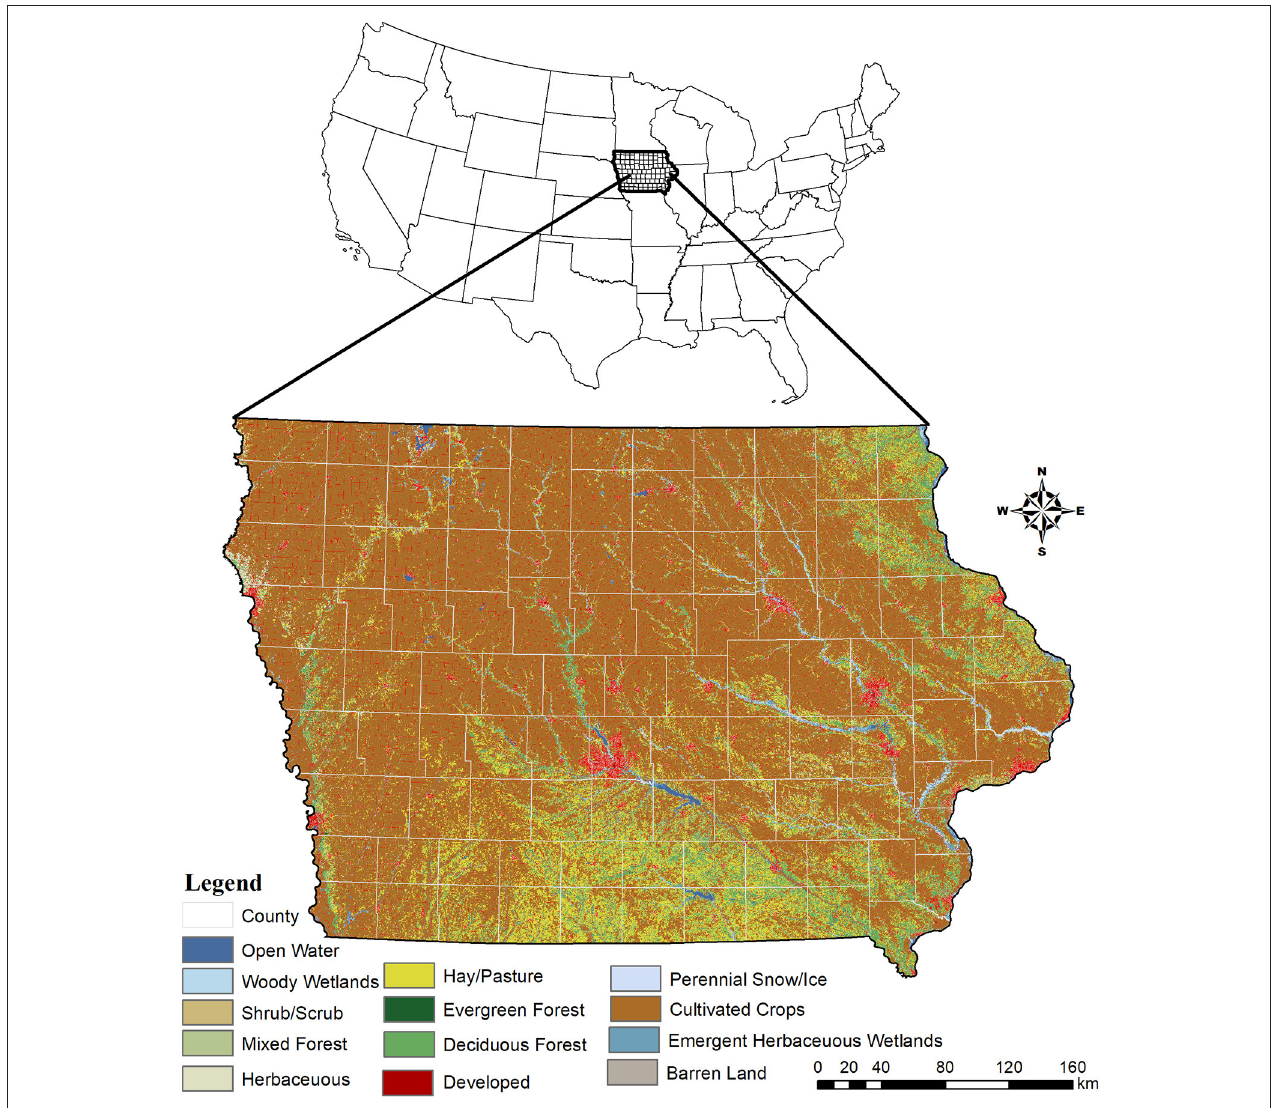
FIGURE 1 | Land use and land cover map of the state of Iowa (Source 2016 National Land Cover